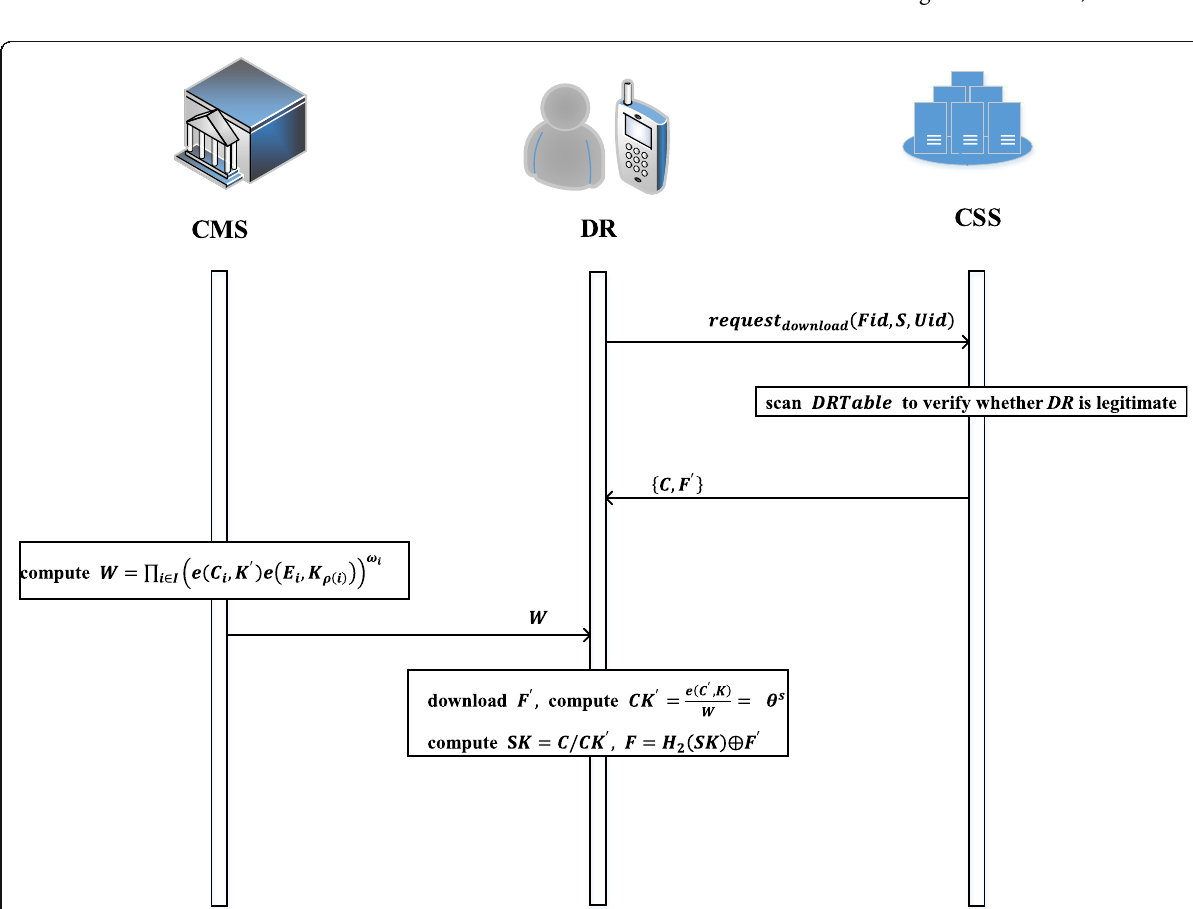
Fig. 5 Data Flow of Sharing